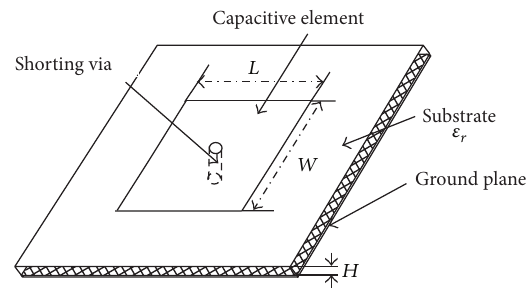
Figure 3: Proposed